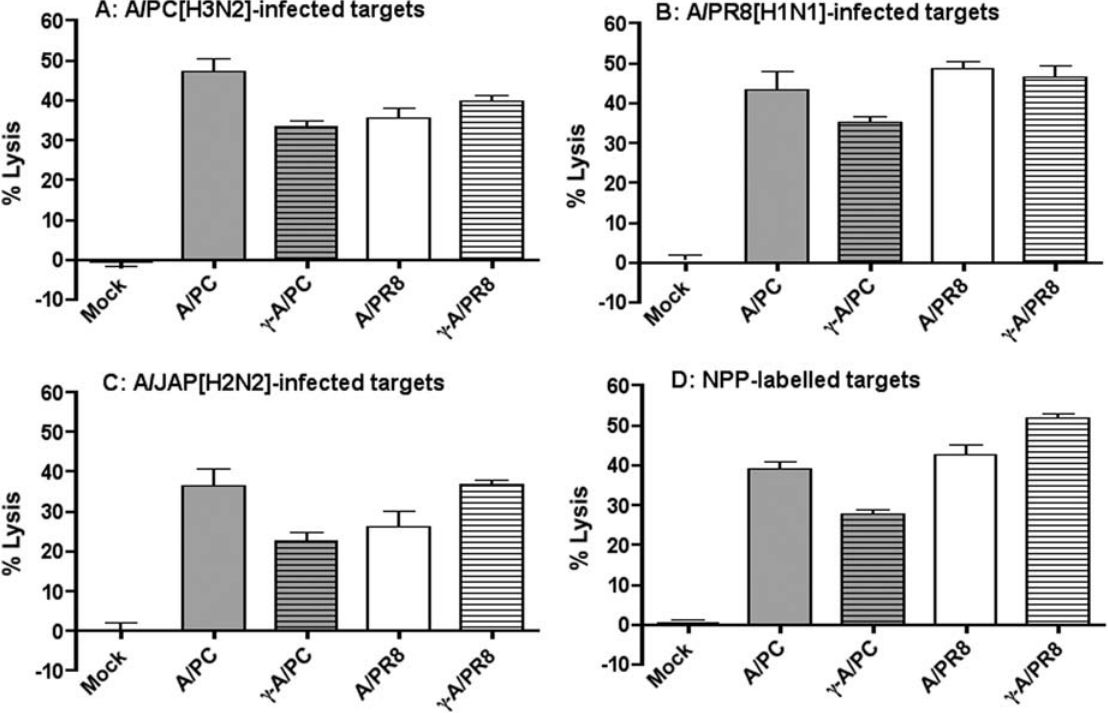
Figure 1. Cross-reactive cytotoxic T cell responses induced by c -Flu. 10-week-old BALB/c mice were either infected or vaccinated with live A/ PR8, c -A/PR8, live A/PC, or c -A/PC. Six days later, splenocytes from these mice were tested for their killing activity against mock, A/PC-, A/PR8-, A/JAP- infected, and NPP-labelled P815 targets. Data represent % specific lysis after 6 h assay time at an effector to target cell ratio of 120:1.